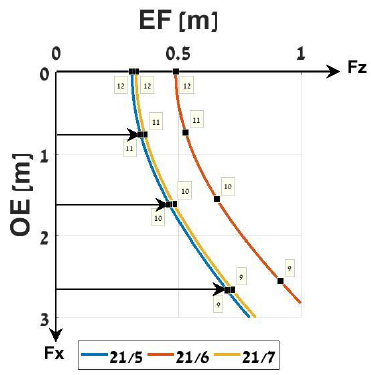
Figure 8. Shadow trajectory of a horizontal pole on a horizontal plate.